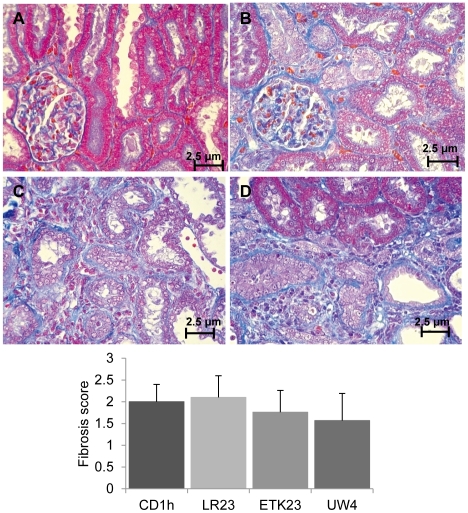
Pathological status of kidney graft after kidney transplantation (RTx).After euthanasia on day 14 after RTx, kidneys were harvested and stained with azan stain for parenchymal fibrosis. Fibrosis was graded numerically as follows; (A): 0 = none, (B): 1 = minimal, (C): 2 = moderate, and (D): 3 = severe. In each slide, 20 fields were evaluated by four observers blinded to treatment (4×20 fields). Fibrosis of the group receiving kidneys preserved with ETK23 tended to be lower than that of the other groups, but the difference was not significant (p>0.05).